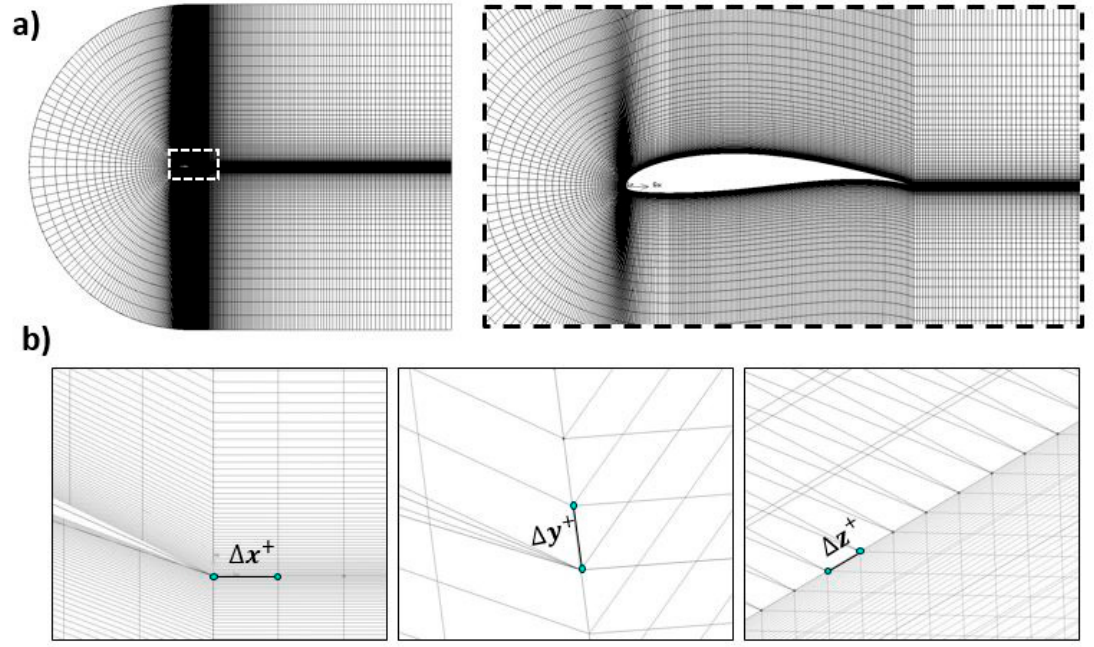
Figure 3. ( a ) Computational mesh. ( b ) Minimum cell sizes in the different coordinates.